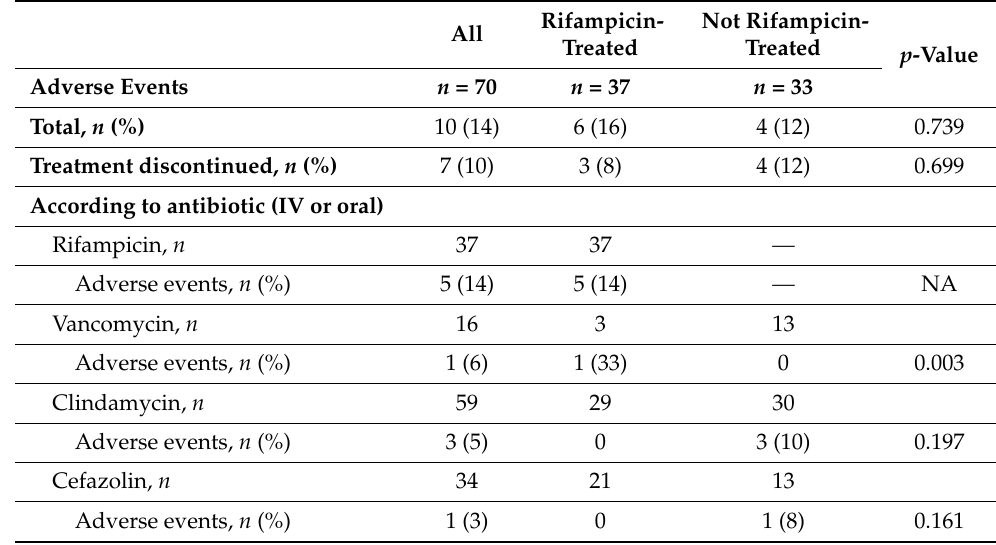
Table 5. Adverse events due to rifampicin, clindamycin, cefazolin or vancomycin.